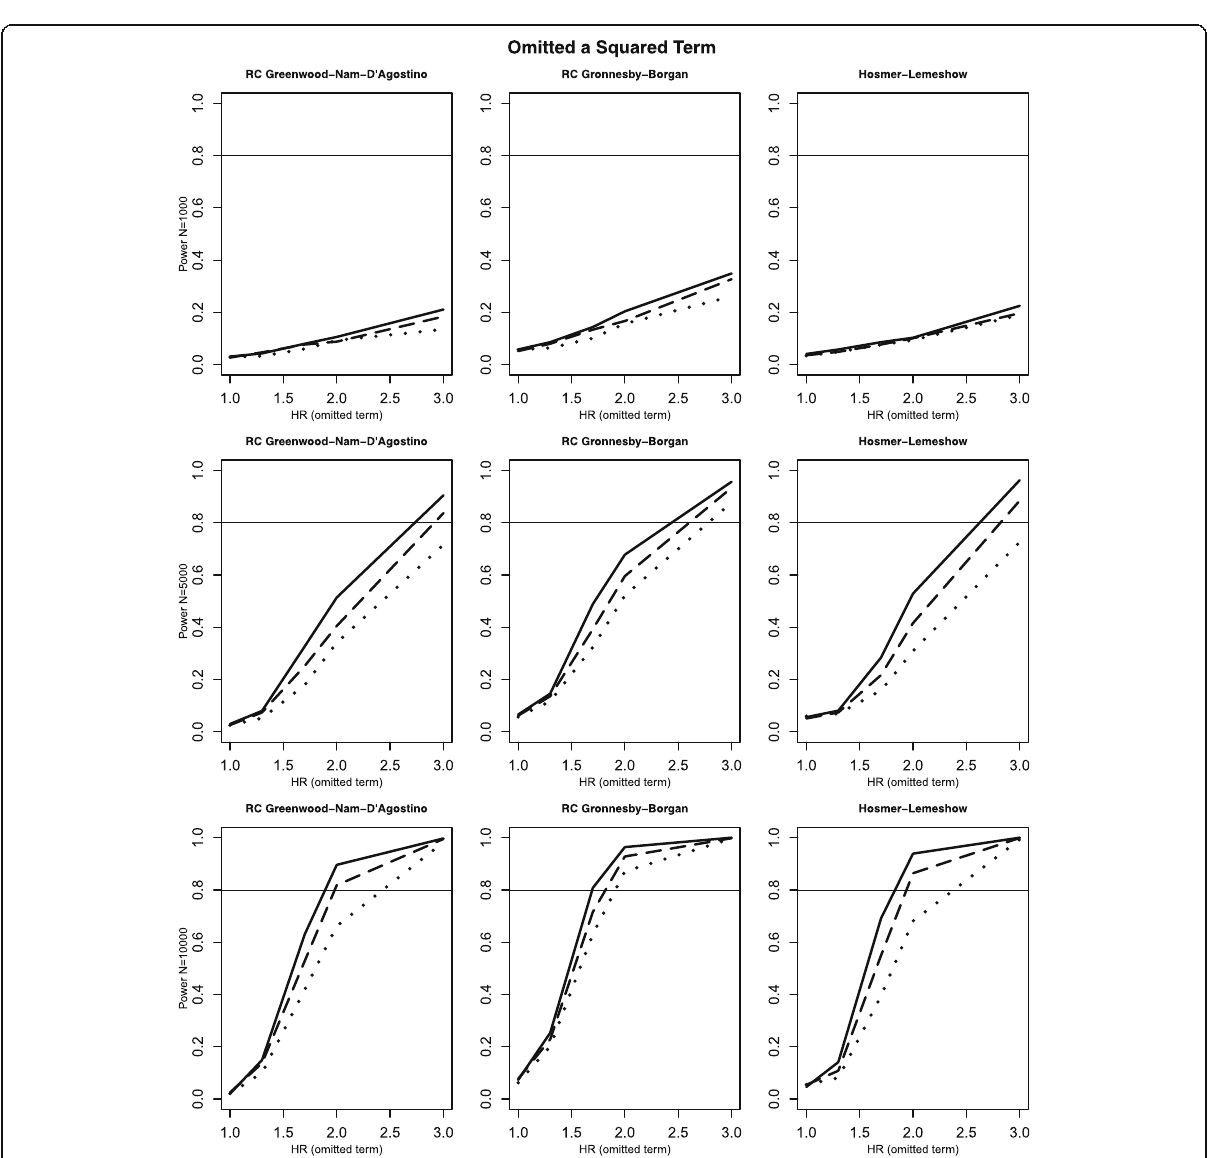
Fig. 4 Power when a squared term is omitted for 0, 25, and 50% censoring rates. The RC statistic was calculated for the full ( y ~ x 1 and x 12 ) and reduced ( y ~ x 1 ) models. Data were simulated according to the full model, but the reduced model was used to estimate the expected proportions in the RC statistic formula. Left panel — decreasing baseline hazard, right panel — increasing baseline hazard. N =1000 (top row), 5000 (middle row), 10,000 (bottom row), p =0.1, collapse when ev g